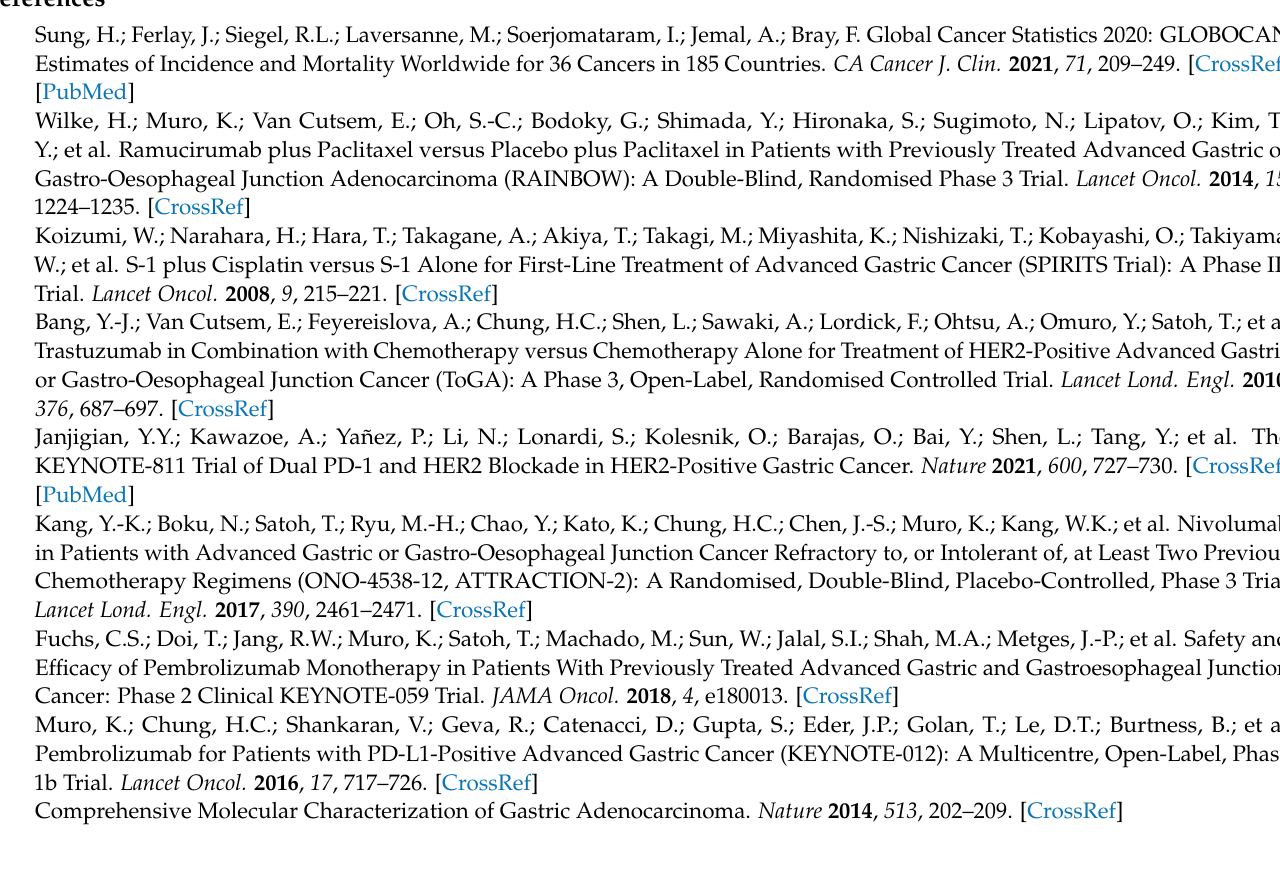
Figure S3. Biological function analysis between high- and low-risk groups in the three cohorts. Figure S4. Relationship between risk score and ACRG molecular subtypes in the GEO validation co- horts. Figure S5. The predictive value of risk score was validated in the testing datasets. Table S1. Dif- ferentially expressed genes. Table S2. Immune-related DEGs. Table S3. Results of univariate regression and multivariate regression analysis of the four included genes. Table S4. Clinical char- acteristics of patients with gastric cancer in 3 datasets. Table S5. SERPINE1 siRNAs sequences. Table S6. The primer sequences of 4 included